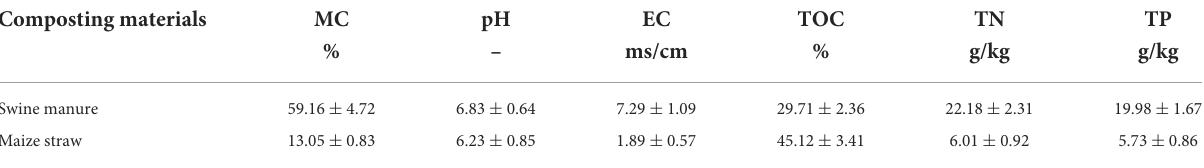
TABLE 1 The physical and chemical parameters of swine manure and maize straw (dry weight basis, n = 3). Composting materials